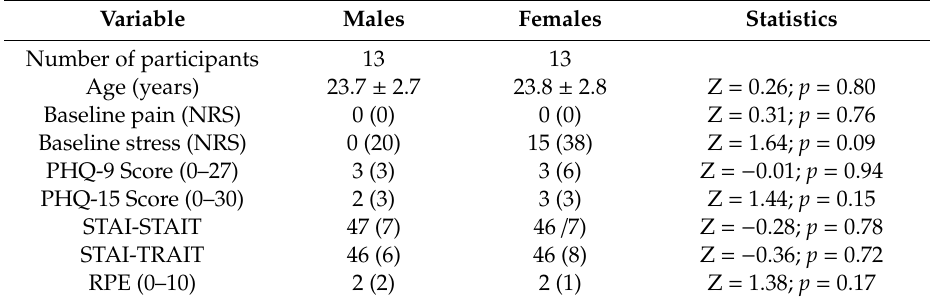
Table 1. Descriptive data. Overview of the participants in the study. Questionnaire scores are presented as mean ± standard deviation or as median (interquartile range). There were no statistical di ff erences between males and females in any of the variables, p > 0.05, Mann–Whitney U -test. Variable Males Females